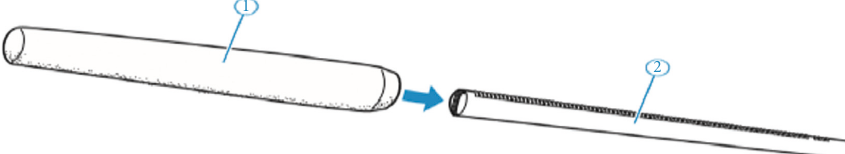
Figure 4: Microphone’s